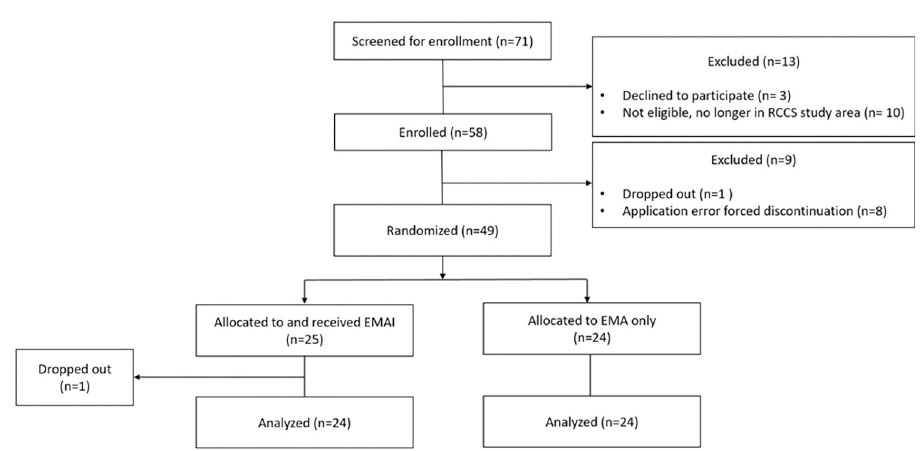
Fig 2. CONSORT flowchart. Figure reproduced from Beres et al, JMIR Form Res., 2021, https://doi.org/10.2196/ 22693.